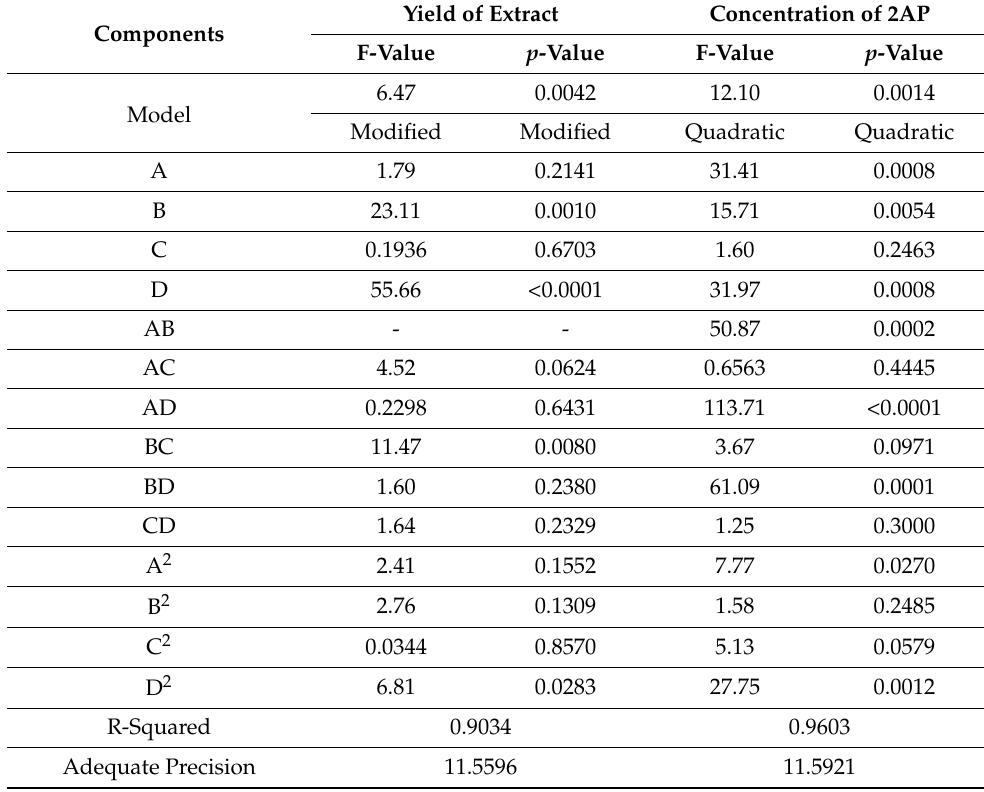
Table 3. RSM best for model fitness parameters (F-value and p